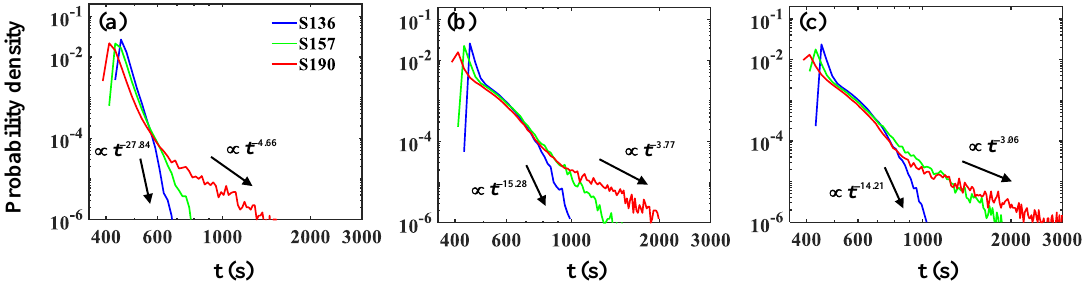
Figure 8. 1D breakthrough curves of S136, S157, and S190, in which particle residence times are measured at the channel outlet, simulated with ( a ) the k − ε model, ( b ) the k − ω model, and ( c ) the SST k − ω model.